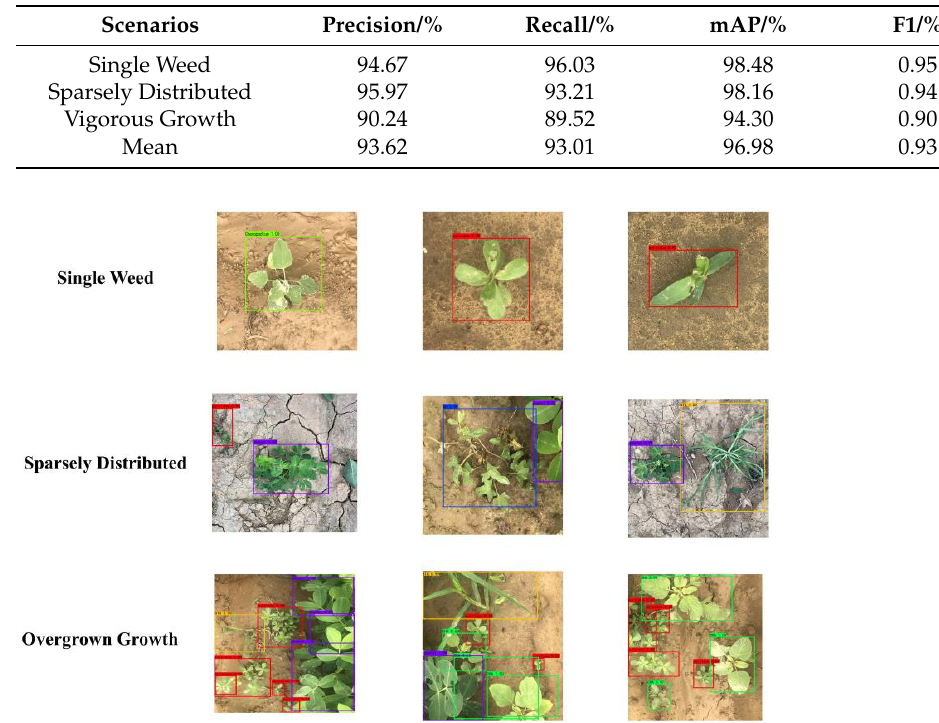
Table 7. Performance comparison results of models in different scenarios.